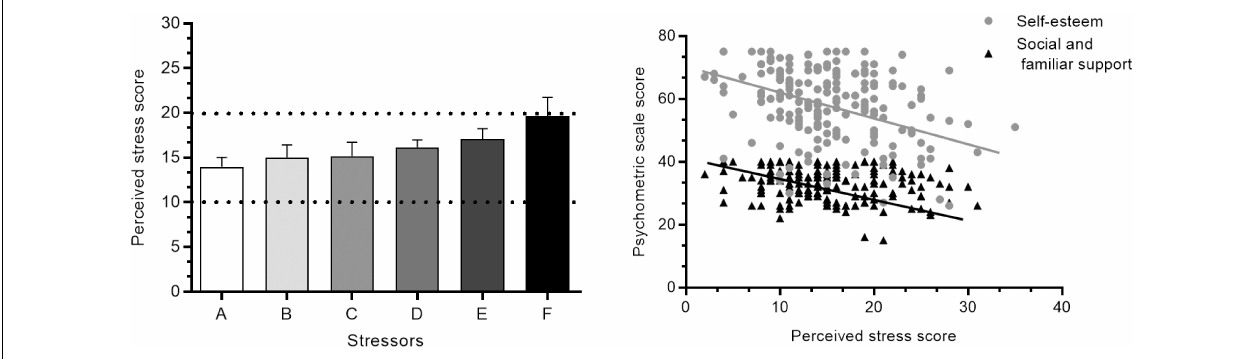
FIGURE 1 | Perceived stress (left) and psychometric correlation (right) . (A) Exams. (B) Eating schedule. (C) Academic failure. (D) Workload. (E) Time distribution. (F) Acceptance by peers. Dash lines show the interval of mild stress score. The results are expressed as mean ±